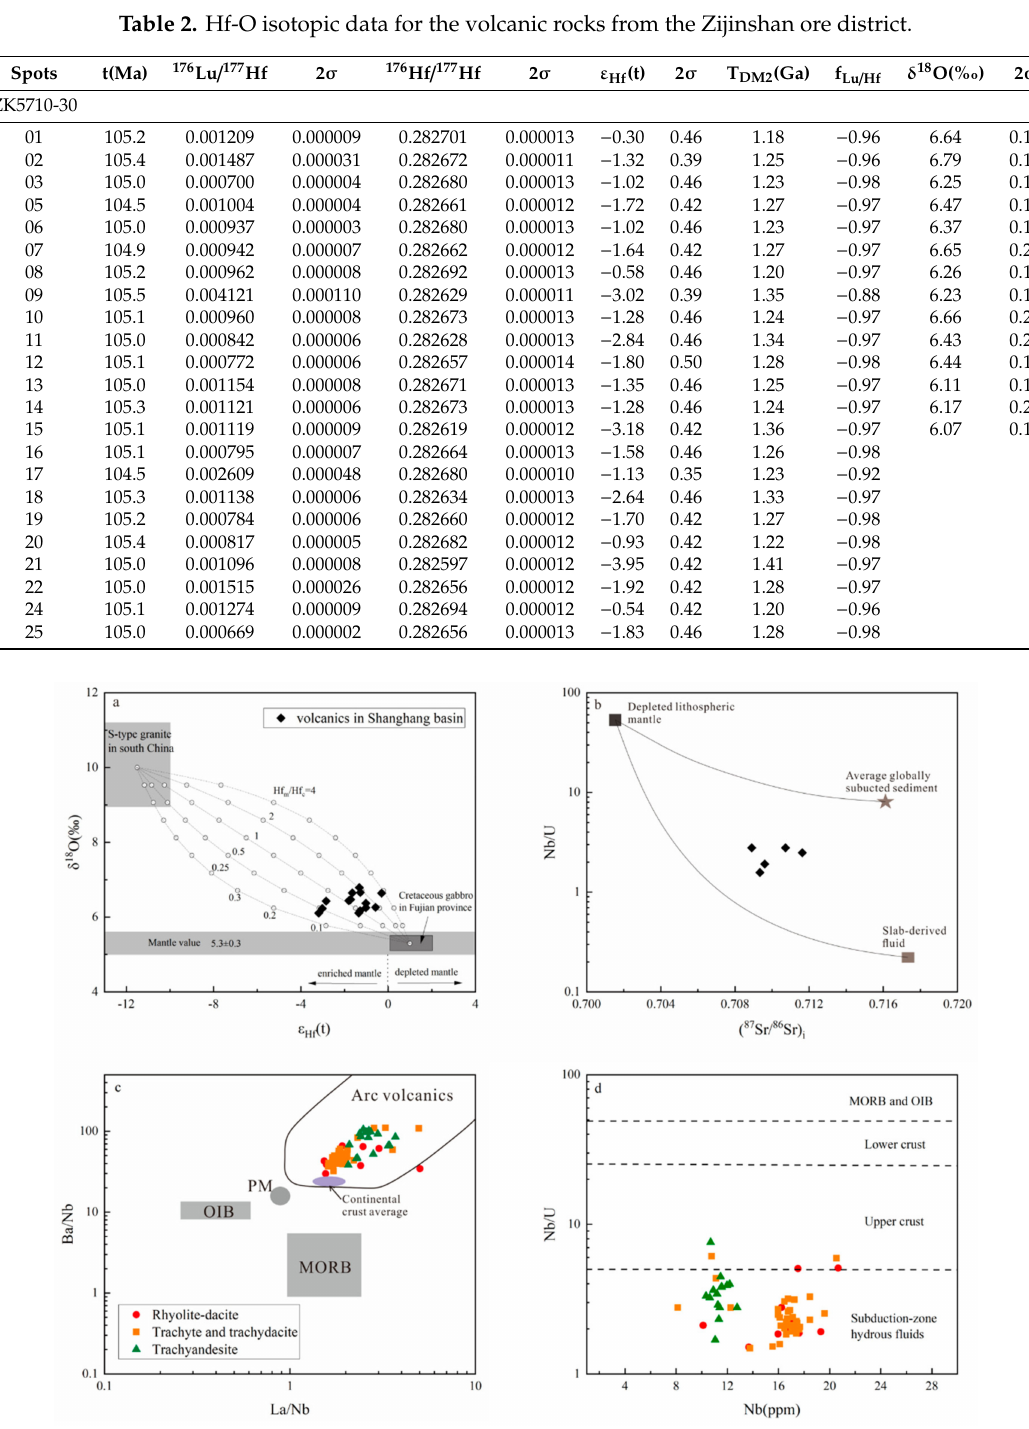
Figure 10. Element and isotope variation diagrams for volcanic rocks from the Shanghang Basin. ( a ) Zircon δ 18 O versus ε Hf (t). The S-type granite compositions are ε Hf (t) = –12 and δ 18 O = 10% (cid:24) . The Fujian Cretaceous gabbro compositions are ε Hf (t) = 1 and δ 18 O = 5.3% (cid:24) . Data for S-type granite in South China and Fujian Cretaceous gabbro are from [55,59,60],; ( b ) The whole rock Nb / U versus ( 87 Sr / 86 Sr) i . Data for globally subducted sediment and slab-derived fluid are from [61,62]; ( c ) The whole rock Ba / Nb versus La / Nb. Data for arc volcanic rocks, average continental crust, OIB, PM, and MORB are from [63]; ( d ) The whole rock Nb / U versus Nb. The regions between the dashed lines are from